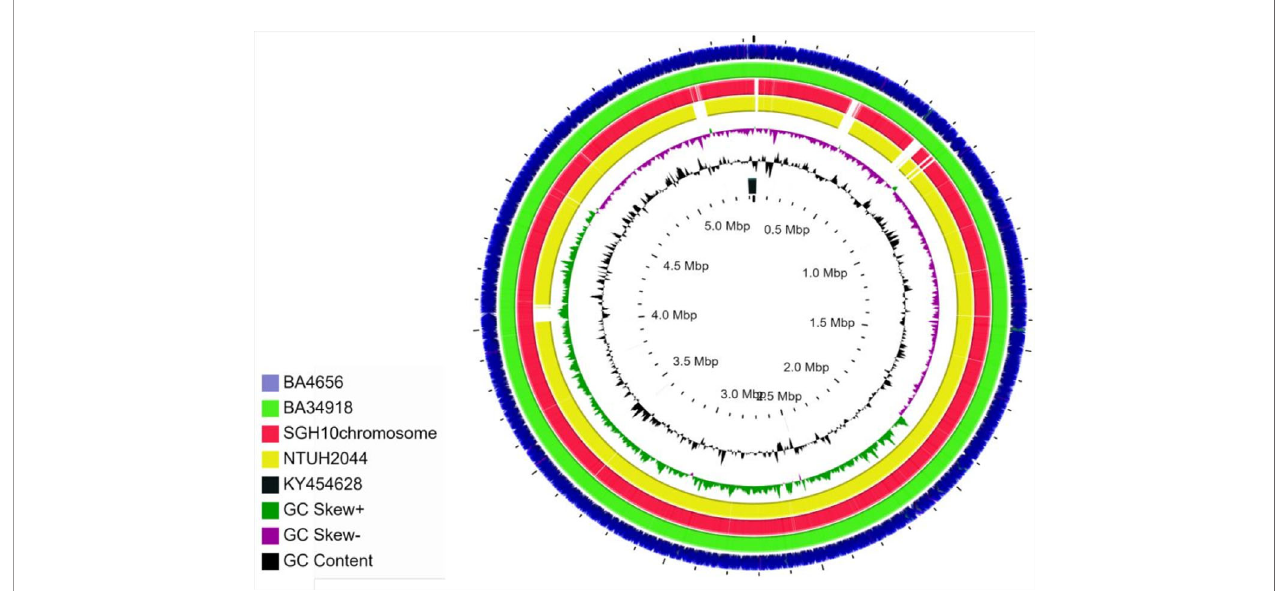
FIGURE 1 | Circular representation of chromosomes of K. pneumoniae isolates BA4656 (NZ_CP035905) and BA34918 (NZ_CP036190) genomes displayed using CG view server with the reference genomes SGH10 (NZ_CP02580) and NTUH-K2044 (NC_012731). KY454628 is the reference used for ICEKp3. SGH10 and NTUH-2044 have ICEKp10 and ICEKp1, respectively. Genomes of BA4656 and BA34918 have numerous insertion sequences (IS) when compared to the reference genomes. These IS elements are represented as gaps in the two reference